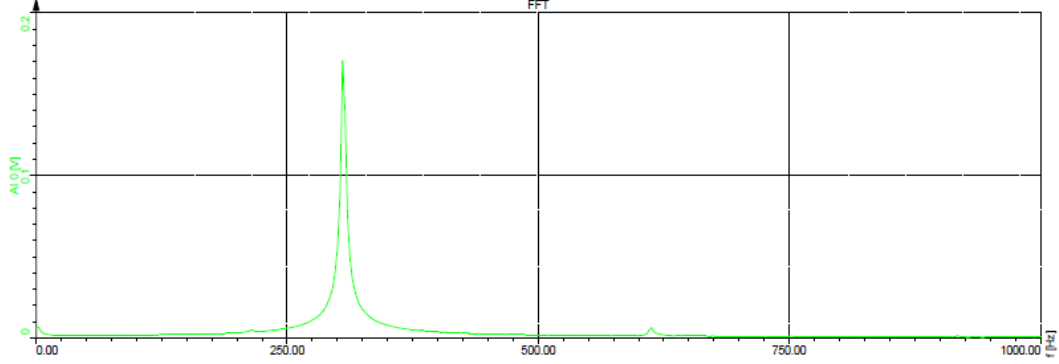
Figure 3: Amplitude response of bare plate with CCCC configuration